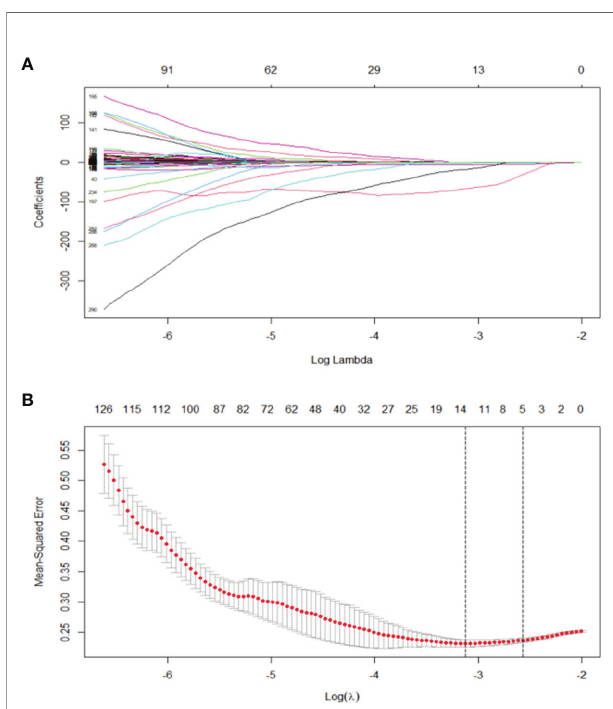
FIGURE 3 | (A) LASSO,least absolute shrinkageand selection operator.A total of 293 radiomics features. (B) Tuning parameter ( l ) selection inthe LASSO model used 10 cross-validation via minimum criteria (the 1-SE criteria).Verticallines were drawn at the optimalvalues. The optimal l ( l = 0.044)resulted in14 features with nonzero coef fi